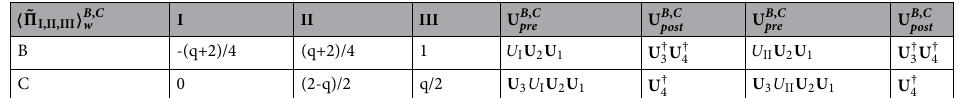
B , C (cid:31) I,II,III Table 3. Weak traces w Eq. (7) of a particle in a noisy Vaidman interferometer at � ˜ � different instants B , C indicated in Fig. 1 and corresponding pre-and postselections given by † respectively. The quantity † and ρ B , C U B , C U B , C U B , C U A , B , C (ρ out � � ) ρ B , C pre pre ( | ψ 0 �� ψ 0 | ⊗ | � �� � | ) [ pre ] post = post post ] ⊗ | �� | [ = (cid:31) (cid:31) (cid:31) (cid:31) q U U with U given in Eq. (10). The effect of pure decoherence indicated by U I occurs = � | � + � | � + − ± for path I after beam splitter BS 2 . The effect of pure decoherence indicated by U II occurs for path II after beam splitter BS 2